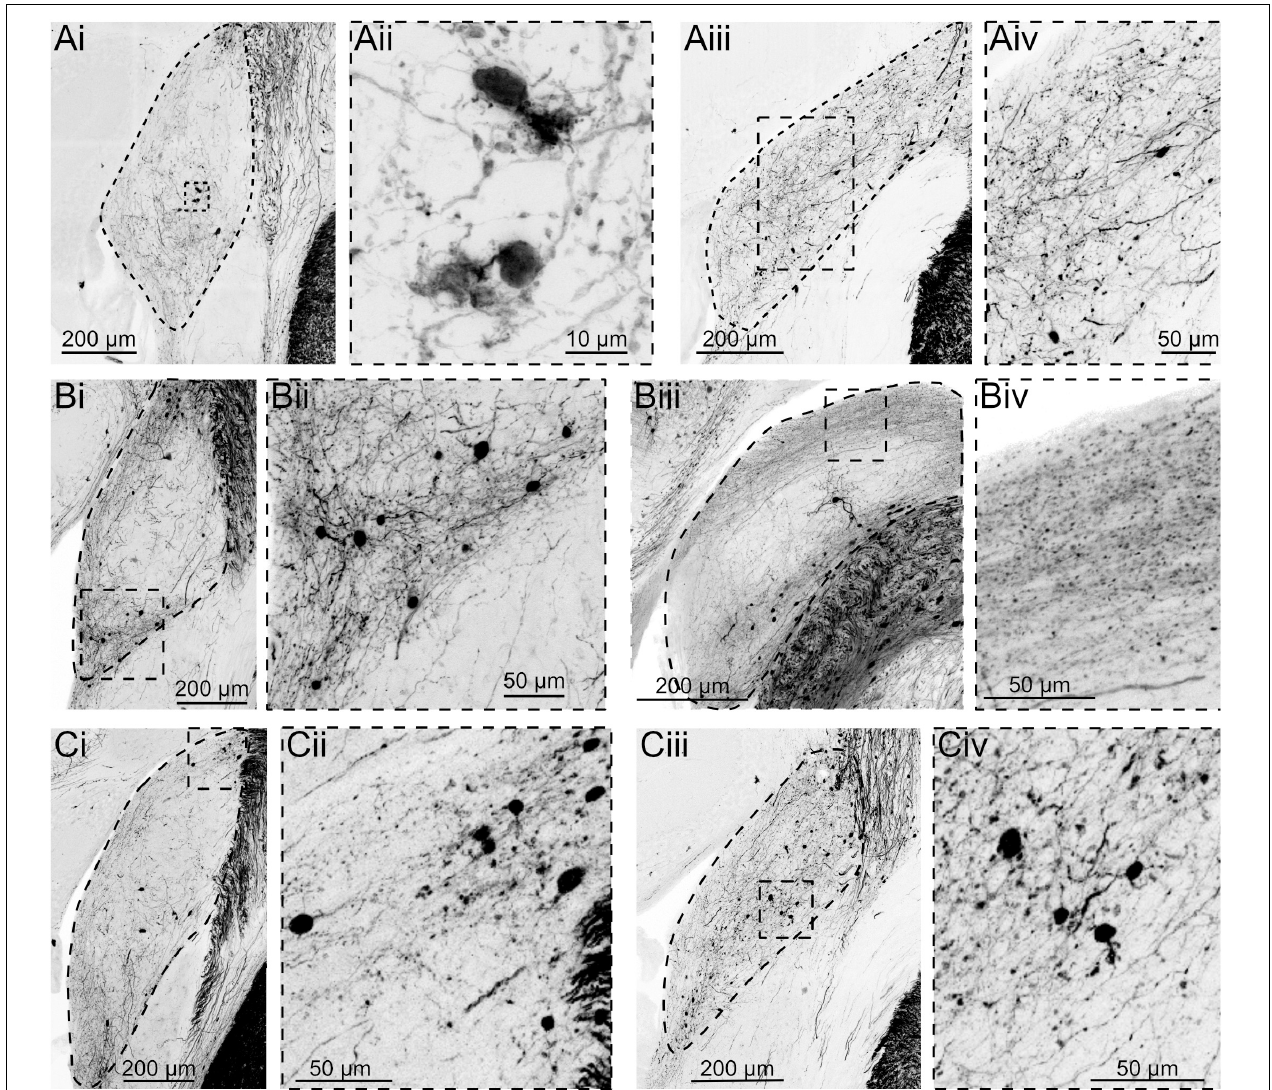
FIGURE 2 | AAV1-Syn-Cre injection into SpV reveals projections to granule domain cells in DCN. Three different experiments, each with two example coronal sections containing DCN. tdTomato labeling is shown in black. DCN is outlined in the lower magnification images. (Ai) Although few neurons are transsynaptically labeled, UBCs can be identified by their distinct morphology. (Aii) Magnification of the boxed region in Ai . (Aiii) A caudal section containing DCN from the same animal. (Aiv) Magnification of the boxed region in Aiii . (Bi) Another experiment showing transsynaptically labeled small cells in the region between DCN and VCN. (Bii) Magnification of the boxed region in Bi . (Biii) A more caudal section of DCN demonstrates labeled parallel fiber axons, confirming that granule cells were labeled transsynaptically. (Biv) Magnification of the boxed region in Biii . (Ci–iv) A third experiment further demonstrating that a small but consistent population of neurons receives synaptic input from SpV